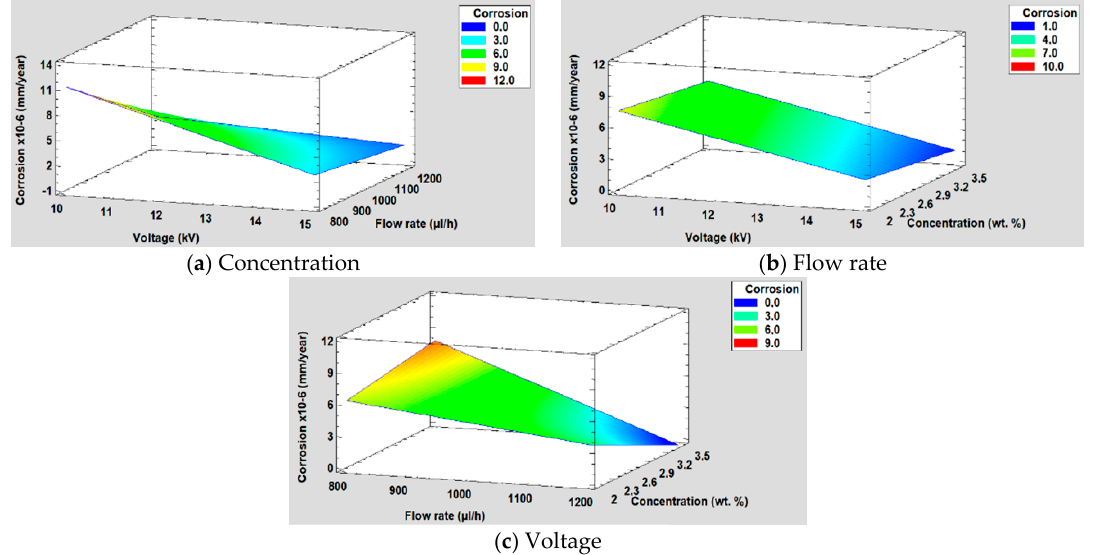
Figure 16. ( a ) Concentration, ( b ) Flow rate and ( c ) Voltage surface response in corrosion resistance.